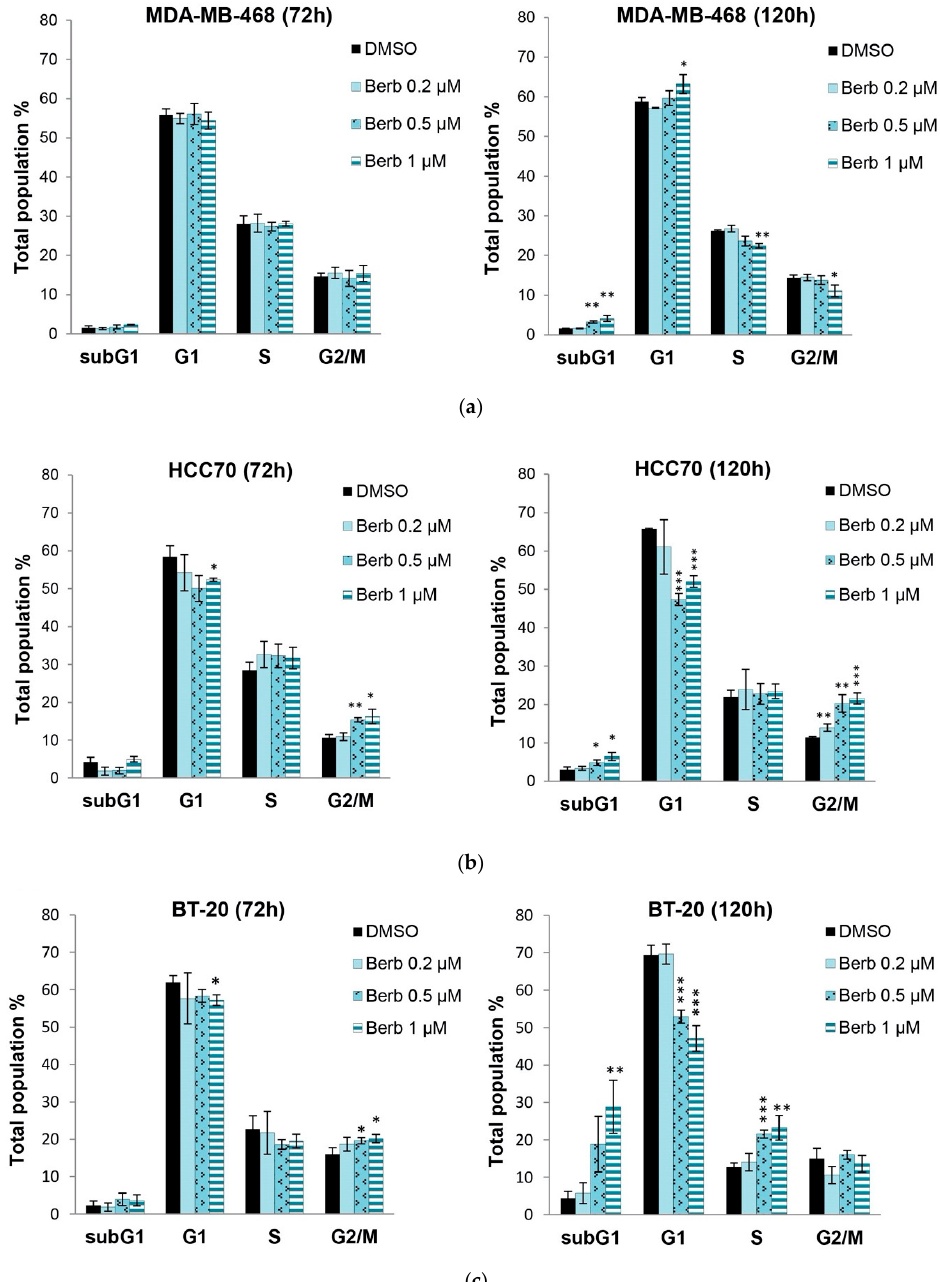
Figure 3. Berberine’s effects on TNBC cell cycle progression depending on its doses (µM) 0.2, 0.5 and 1, and time for 72 h and 120 h. Total population % of cell cycle phases (G1, S, G2/M and SubG1) ± SD of three independent experiments, * p < 0.05, ** p < 0.01 and *** p < 0.001 compared to DMSO. ( a ) MDA-MB-468, ( b ) HCC70 and ( c ) BT-20.